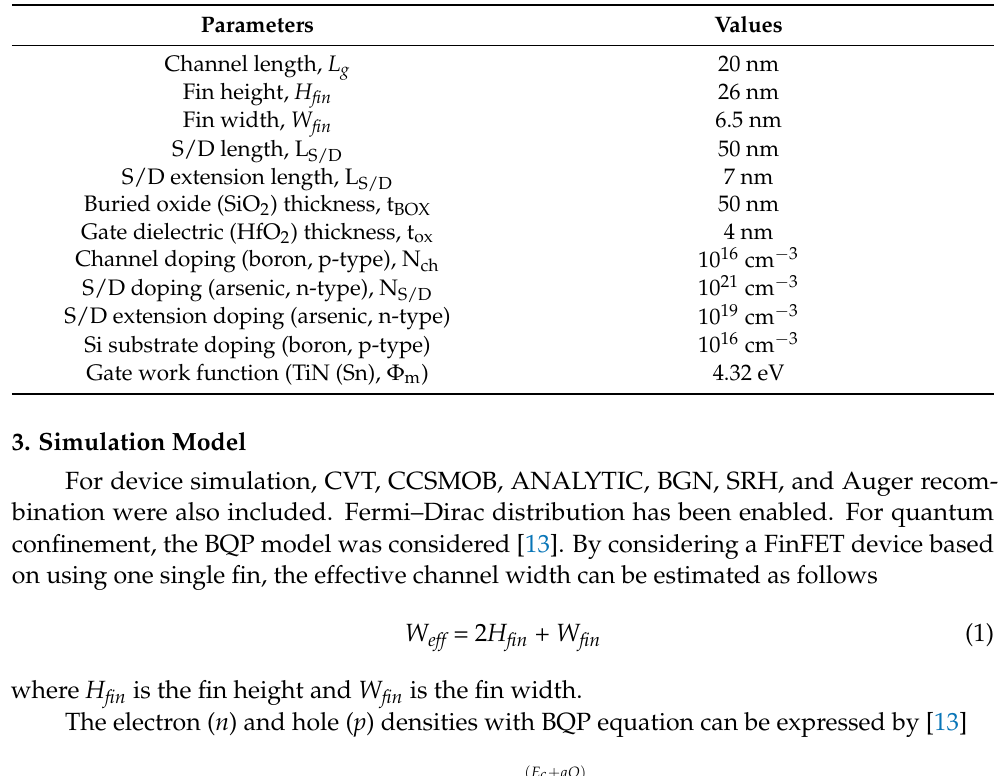
Table 1. Device parameters for a 14-nm